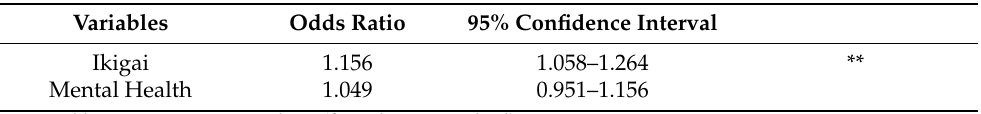
Table 2. Results of logistic regression analysis on high and low life